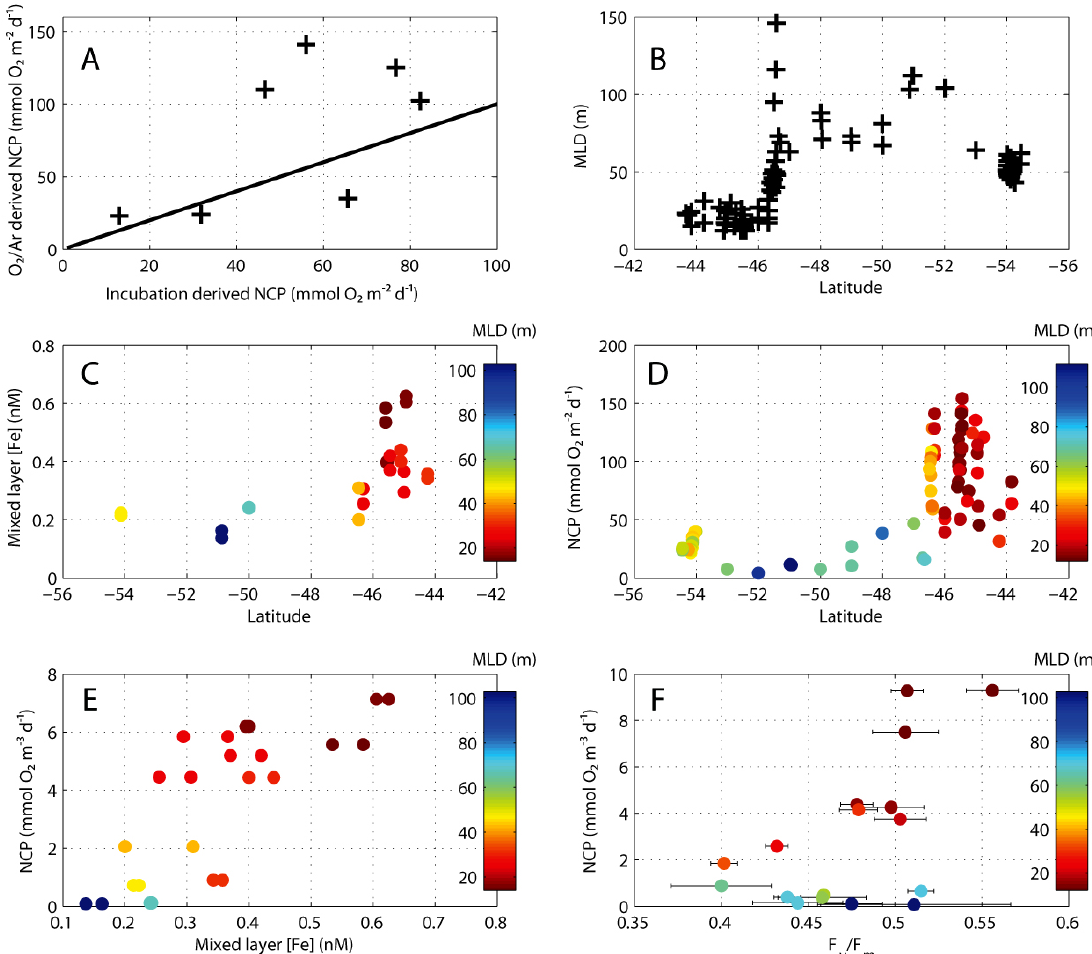
Fig. 3. (A) Mixed-layer O 2 /Ar derived Net Community Productivity (NCP) vs. oxygen incubation derived NCP estimates. Identity slope is also represented (1:1). (B) Mixed layer depth as a function of latitude for the SAZ Sense cruise. Latitudinal variations in average mixed layer dFe concentration (nM) (C) and NCP integrated over the mixed layer (D) . Volumetric NCP as a function of average mixed-layer dFe concentration (nM) (E) and variable fluorescence (F) . Points in (C–F) are color-coded for mixed layer depth (m). MLD is defined as the first depth where the seawater density is 0.05kgm − 3 greater than at 10m (Rintoul and Trull, 2001). Error bars in (F) represent the standard error of triplicate F v / F m